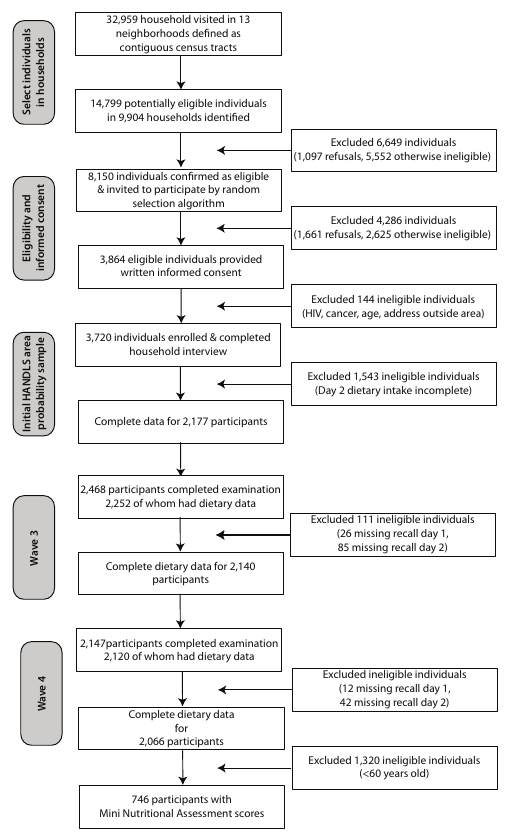
Figure 1. Participants completing two dietary recalls at each HANDLS study wave and participants with Mini Nutritional Assessment Scores. HANDLS—Healthy Aging in Neighborhoods of Diversity across the Life